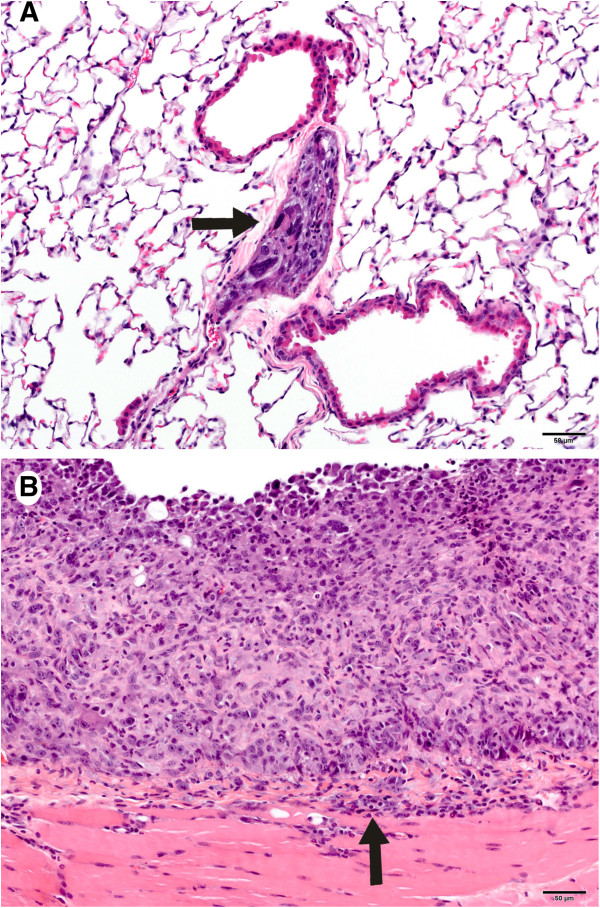
Malignant serosal tumors in the lung (A) and the diaphragm (B) in mice exposed to MC followed by MWCNT. A. The photomicrograph shows a pulmonary vein in the right cardiac lung lobe that contained variably-sized polygonal to spindloid cells similar to those on the diaphragm (Figure 8B). The arrow indicates a metastasis of the malignant serosal tumor (20×). The magnification bar is 50 microns. B. The skeletal muscle of the diaphragm in the photomicrograph is infiltrated by a nodular mass composed of variably-sized polygonal to spindloid cells (malignant serosal tumors). (20×). The magnification bar is 50 microns.